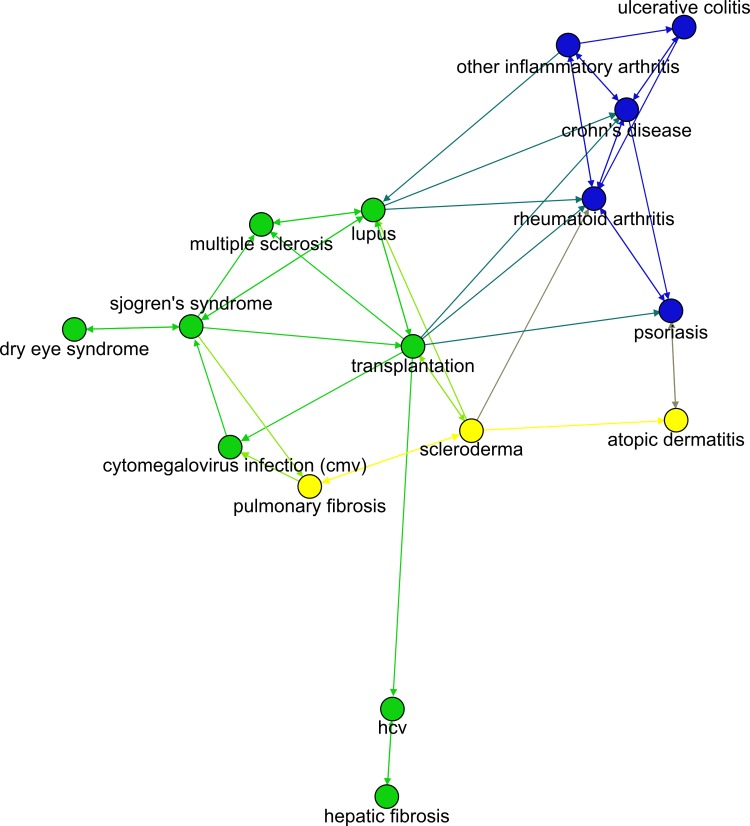
Autoimmune subnetwork based on the Trial dataset.Node colors reflect modularity.